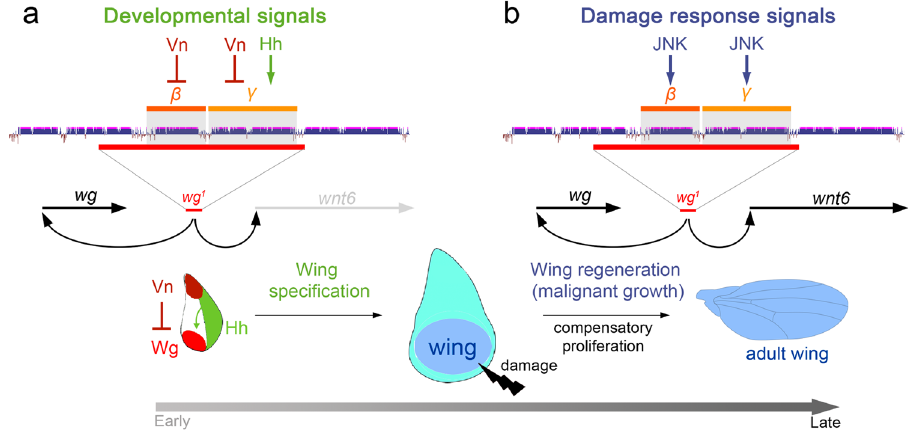
Fig. 8 | A Wnt enhancer devoted to wing fate speci fi cation, regeneration and malignant growth. a , b Cartoons depicting the redundant roles of Beta and Gamma CRMs of the wg 1 - enhancer in responding to developmental ( a ) or damage response signals ( b ), and in driving wing speci fi cation through the